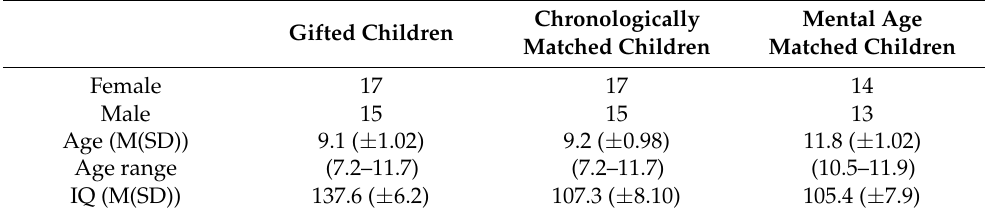
Table 1. Socio-demographic Characteristics of Participants at